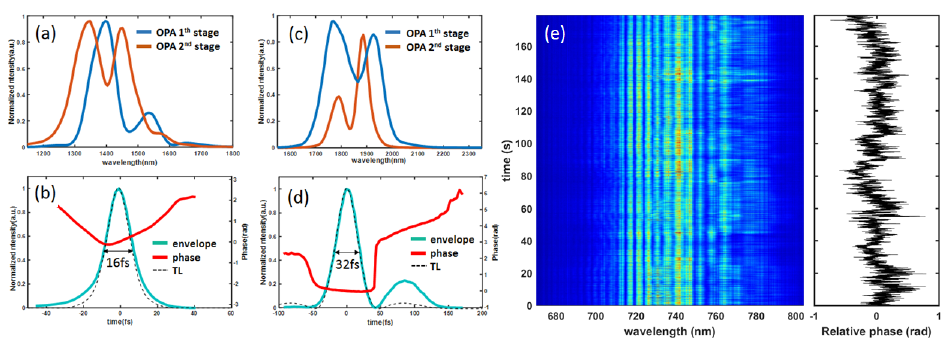
Figure 5. ( a ) Measured spectral intensity of the signal pulse after the first (blue) and the second (orange) OPA stages tuned at 1.4 µ m; ( b ) reconstructed temporal intensity profile corresponding to a pulse duration of 16 fs; ( c ) measured spectral intensity of the signal pulse after the first (blue) and the second (orange) OPA stages tuned at 1.9 µ m; ( d ) reconstructed temporal intensity profile corresponding to a pulse duration of 32 fs; ( e ) a sequence of interferograms acquired with an f -2 f interferometer. In the right panel, the CEP fluctuations are shown corresponding to an rms value of 200